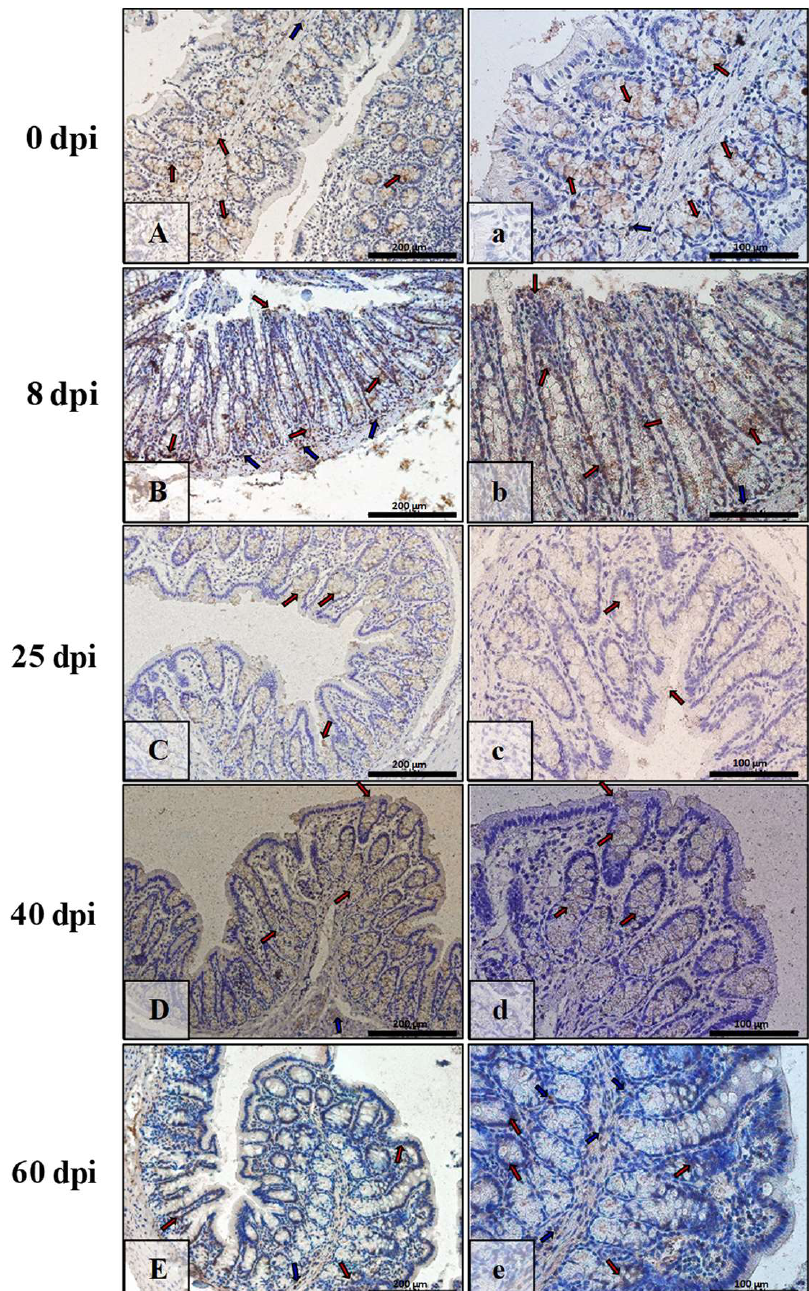
Figure 10. Representative microphotographs showing Bcl-2 immunoexpression in the colon of control animals ( A , a ) and on consecutive days ( B , b , C , c , D , d , E , e ) after H. diminuta infection. Positive IHC reaction—brown reaction indicated by arrows: red—epithelial cells of the intestinal villi and crypts, blue—cells in the connective tissue lining of the mucosa,. Lens magnification: ×20 ( A – E , scale bar: 200 μm), ×40 ( a – e , scale bar: 100 μm).